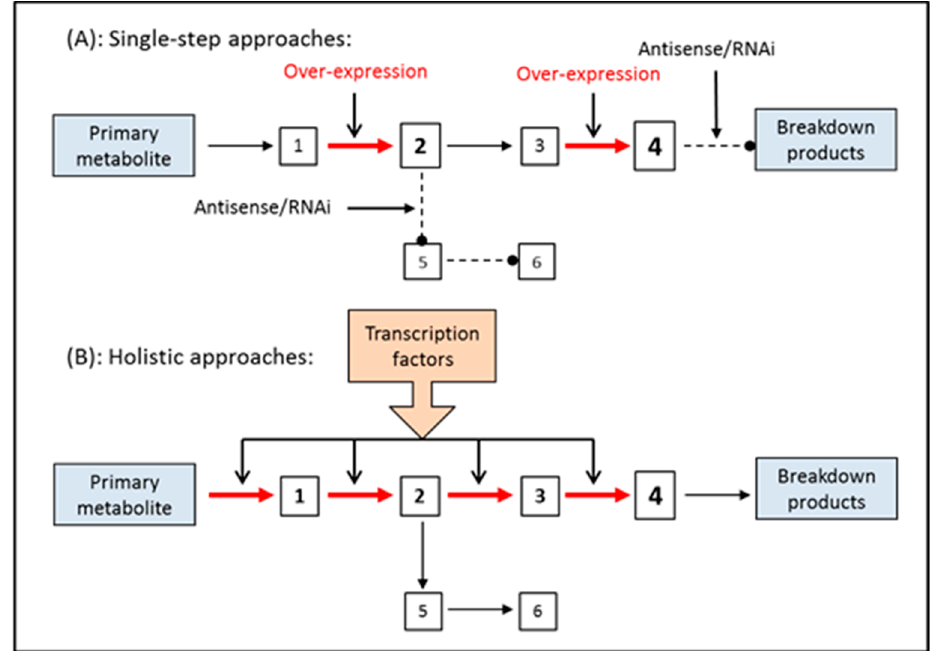
Figure 7. Comparative scheme of single-step and holistic approaches in plant metabolic engineering (modified from Onrubia et al. [187]).